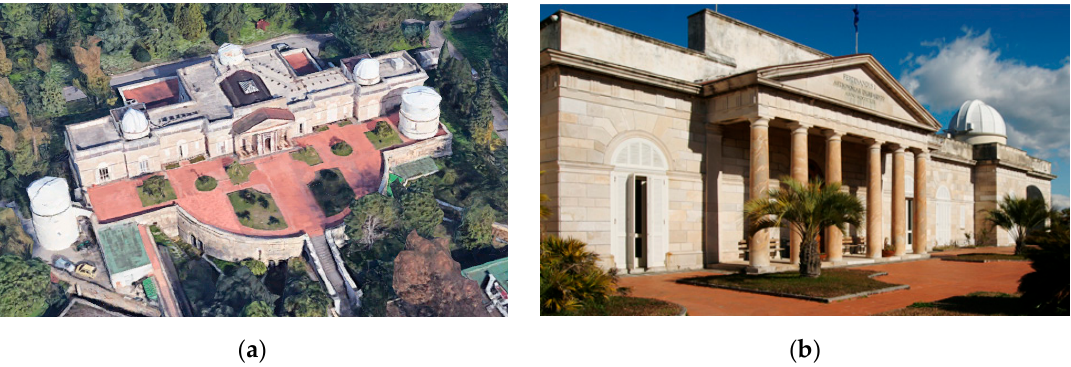
Figure 1. ( a ) General overview; and ( b ) main entrance of the building